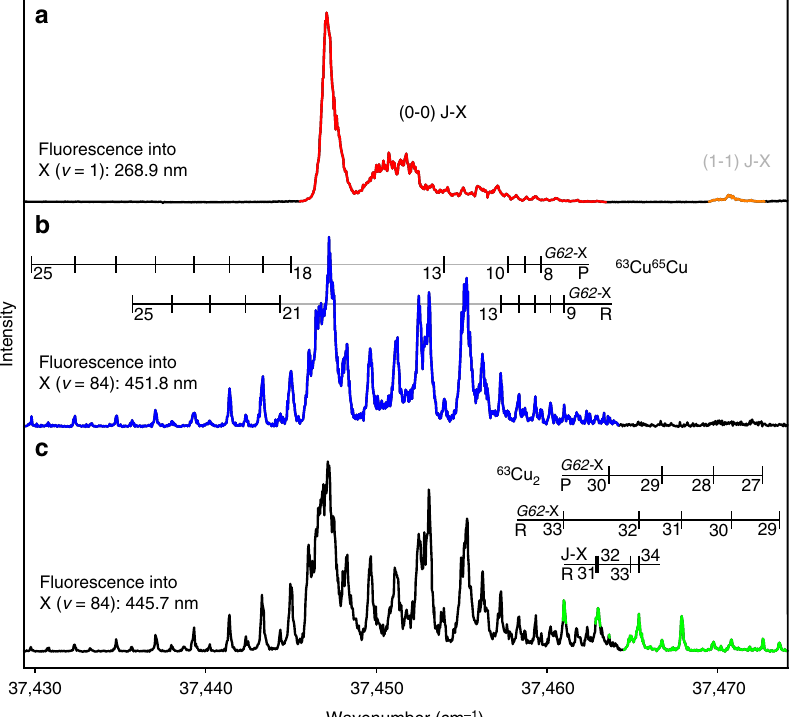
- X 0 þ region of the copper dimer. a Fluorescence of u g and u